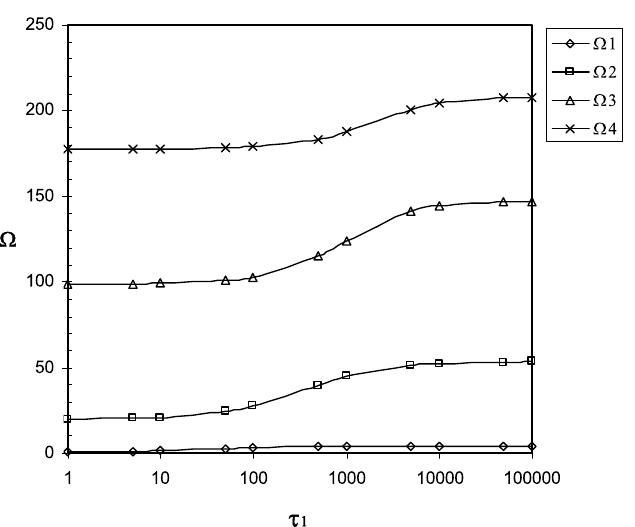
Fig. 3. The fi rst four coupled eigenfrequencies of a SSSS square plate with one sprung mass at its centre ( ξ 1 = η 1 = 0 . 5 ), with respect to the stiffness ratio τ 1 when the mass ratio γ 1 is equal to 5.